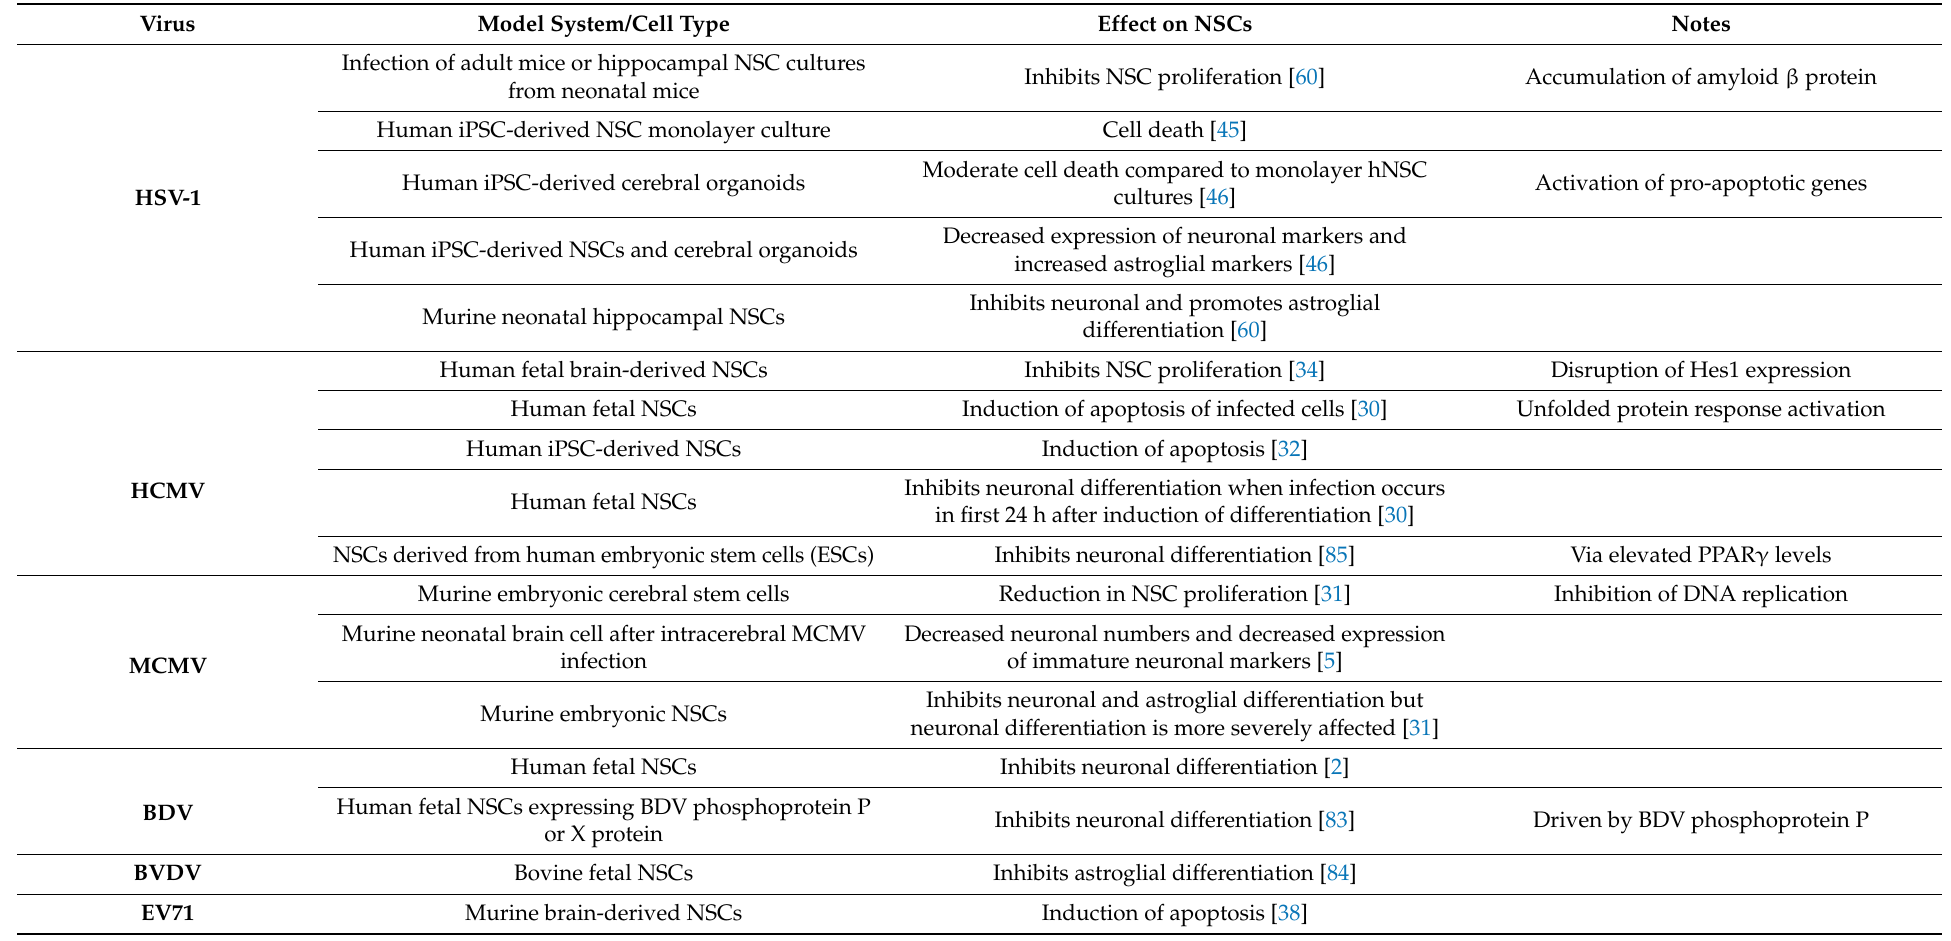
Table 1. Effects of viral infections on NSC proliferation, survival, and